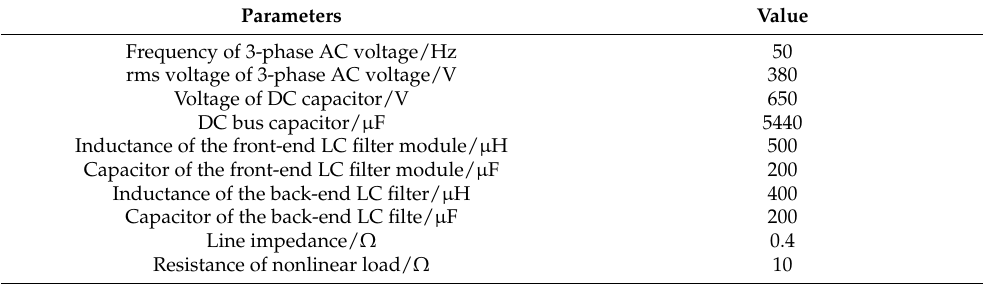
Figure 7. The system simulation model and experimental platform. Table 1 shows the parameter settings of the system simulation model. Table 1. System parameters. Table 1. System parameters.